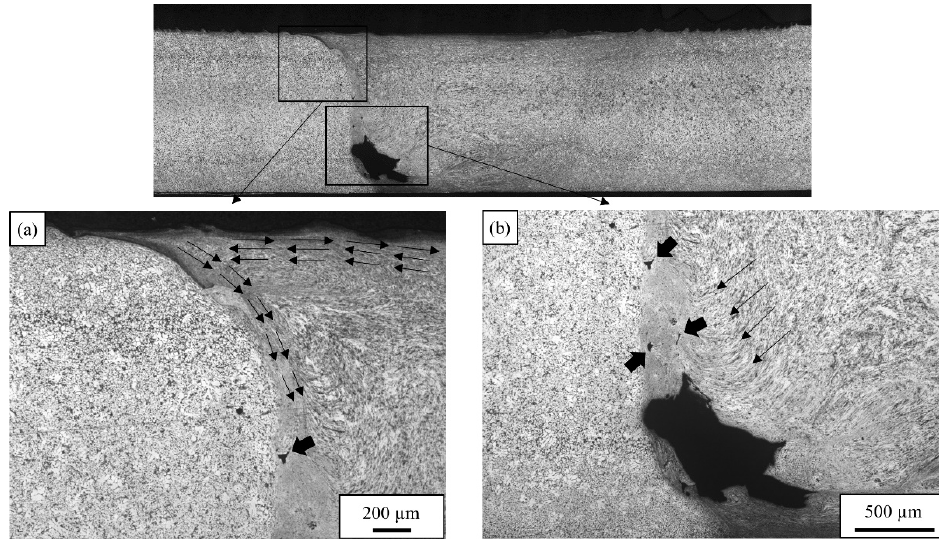
Figure 11. Detail of the defects located on the zone affected by ( a ) the shoulder; and ( b ) the probe in the AlMg4Fe2 weld performed at a welding speed of 1000 mm/min. Thin arrows indicate material flow direction and thick arrows indicate small cavities .